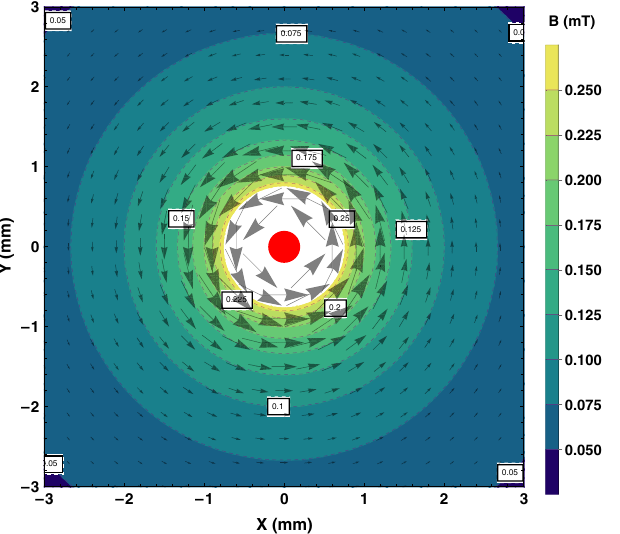
FIG. 3. Electric field lines around the round beam for a beam current of 1